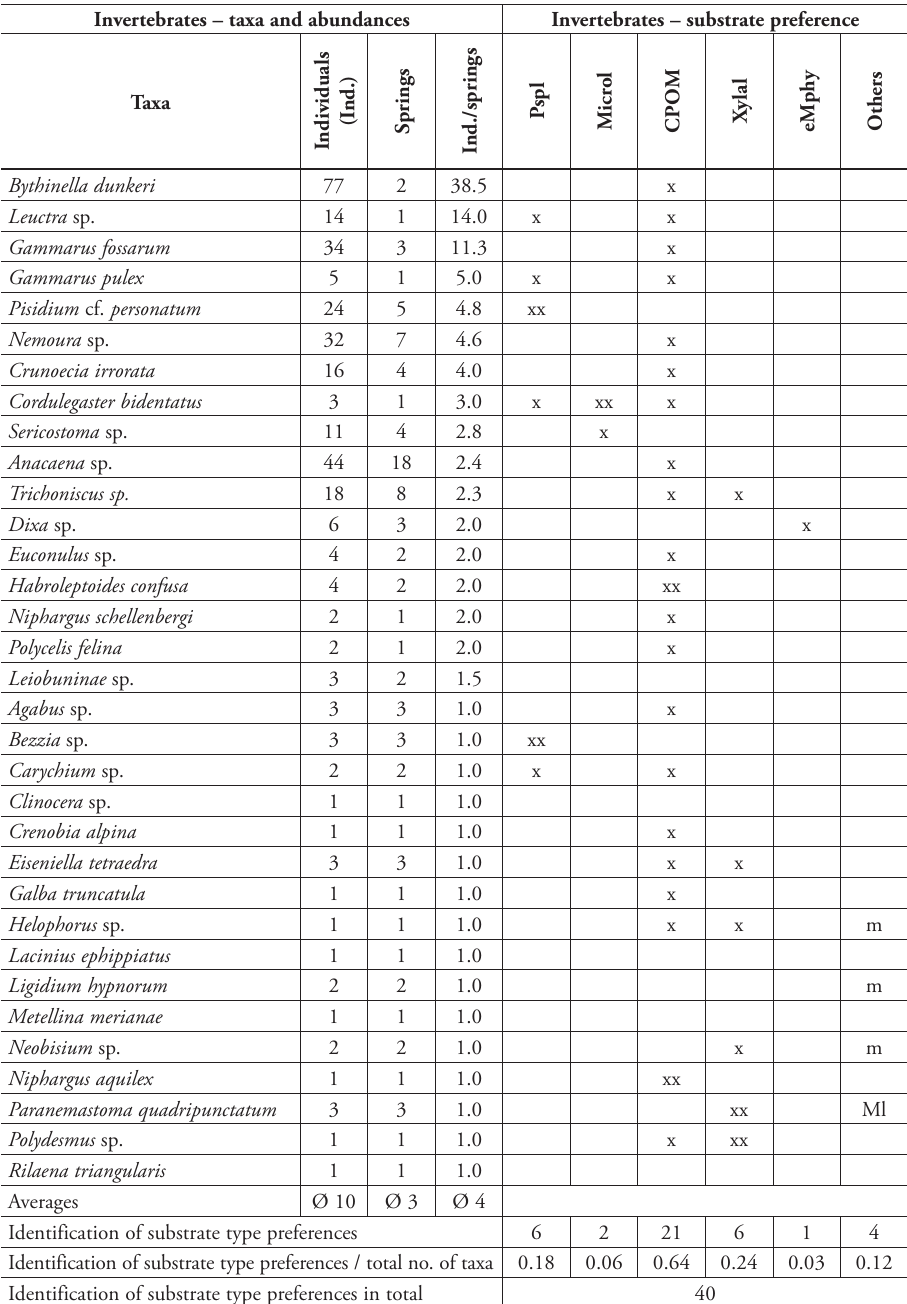
Table 5. Taxa list of springs within coniferous forest land cover. x: good substrate type preference identifi- cation; xx: very good substrate type preference identification; m – mosses; Ml – Megalith (spring dwelling taxa are in